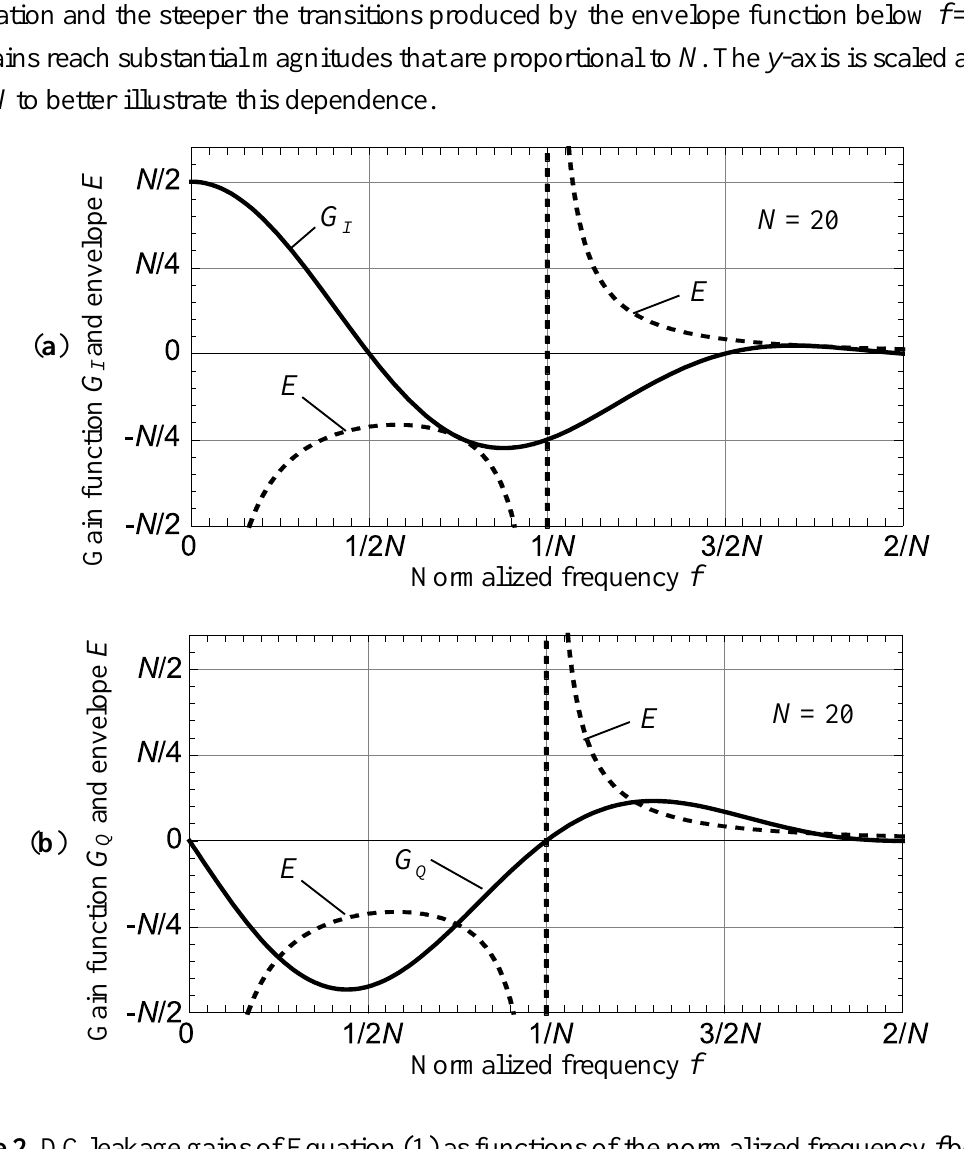
Figure 2. DC leakage gains of Equation (1) as functions of the normalized frequency f below f = 2/ N : ( a ) in-phase component G I ; and ( b ) quadrature component G Q